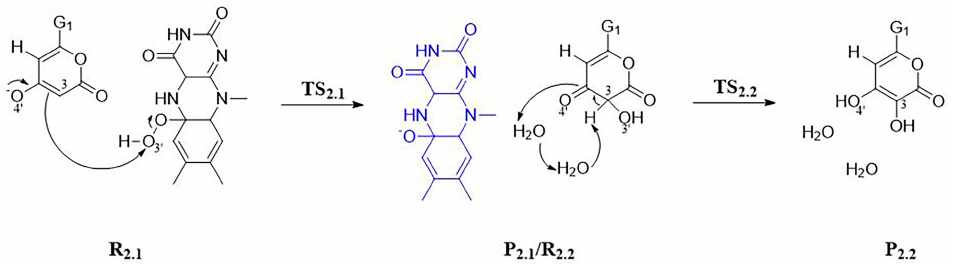
Scheme 6. The reaction process and predicted reaction mechanism of Step 2 of Stage 1. Blue molecules represent product molecules not involved in the next reaction. Group G 1 is shown in Scheme 1.